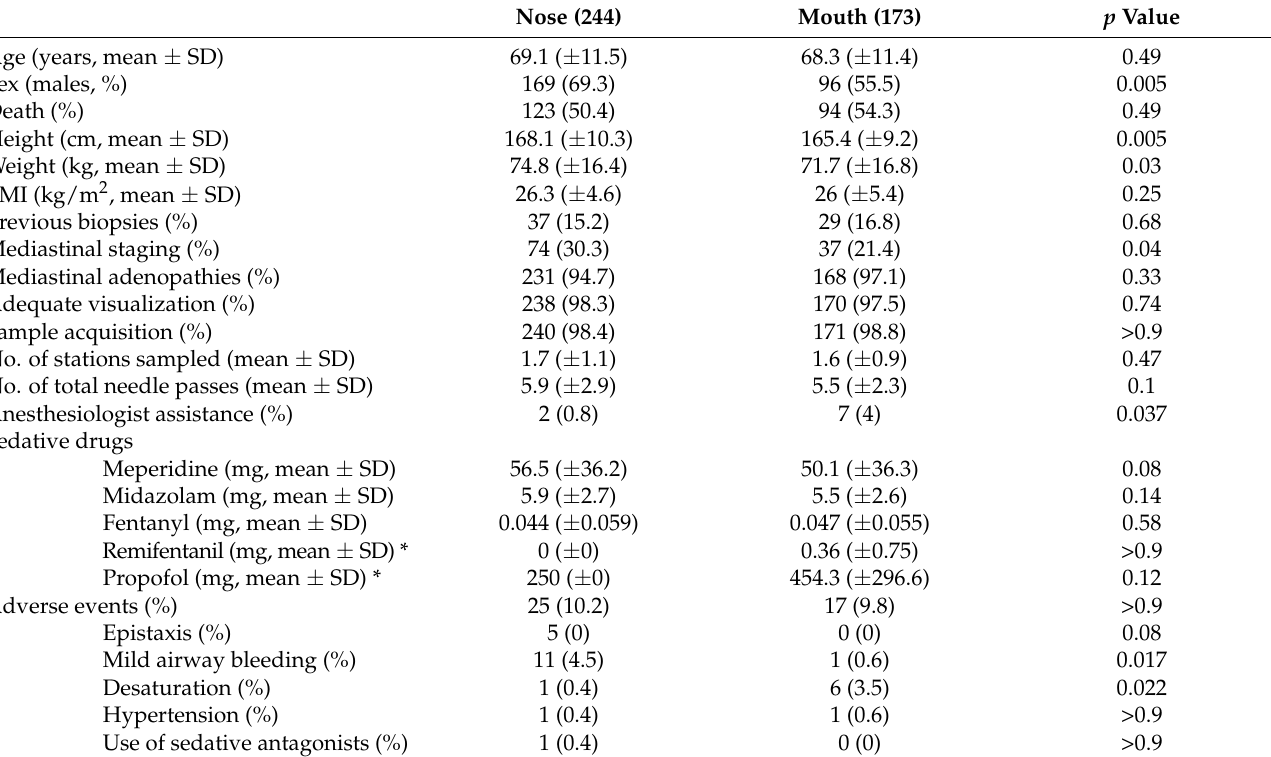
Table 3. Anagraphics, data regarding samples, procedural sedation, adverse events, and result comparisons between the nasal and oral access groups. * The mean, SD, and p values of propofol and remifentanil have been calculated, taking into account only cases with anesthesiologist assistance. SD, standard deviation; BMI, body mass index; NSCLC, non-small cell lung cancer; SCLC, small cell lung